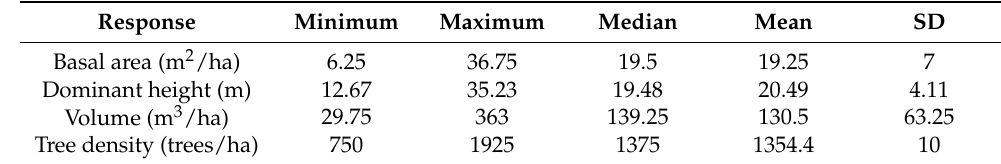
Table 4. Summary statistics of forest attributes from ground measurement.